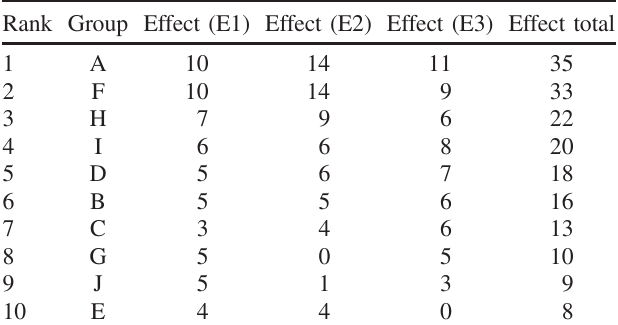
TABLE IV. Groups ’ effectiveness score (Effect) for each epi- sode and ranked by total effectiveness score from highest to